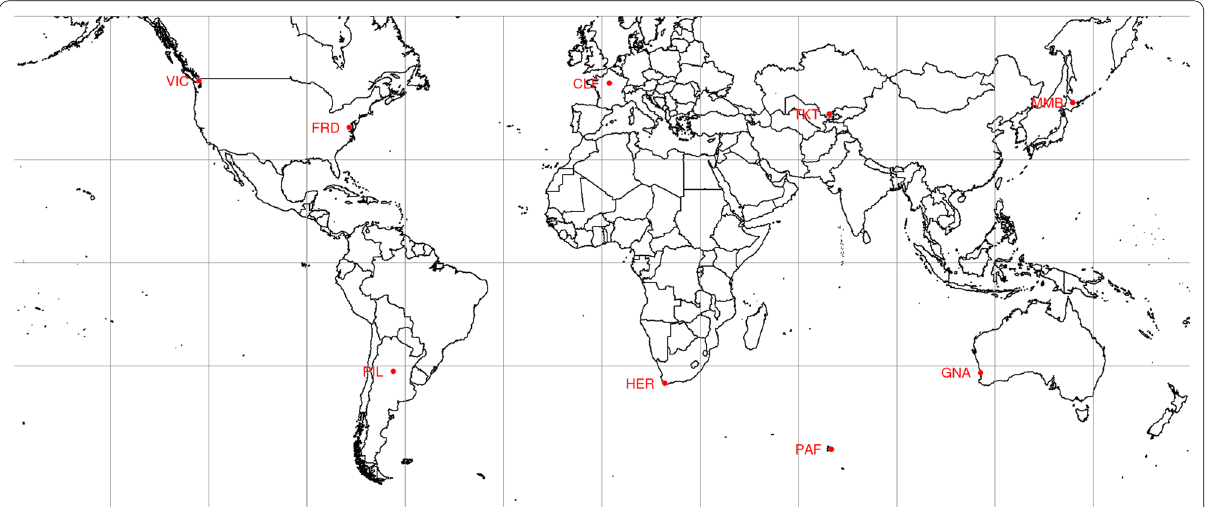
Fig. 11 Map of locations of the considered observatories along with their IAGA codes in the latitudinal range from 30° to 50° in both